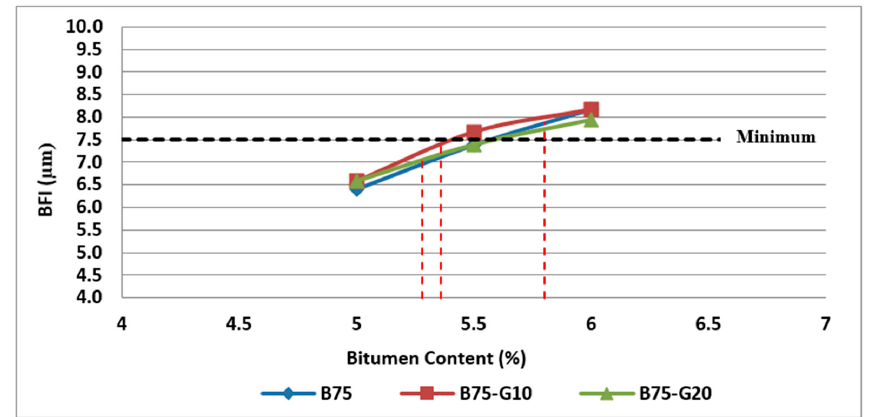
Figure 20. Effect of bitumen content and glass content on BFI of Mix II containing 25% RCA without glass and Mix IV and Mix V containing 25% RCA as coarse aggregate and glass as fine aggregate.